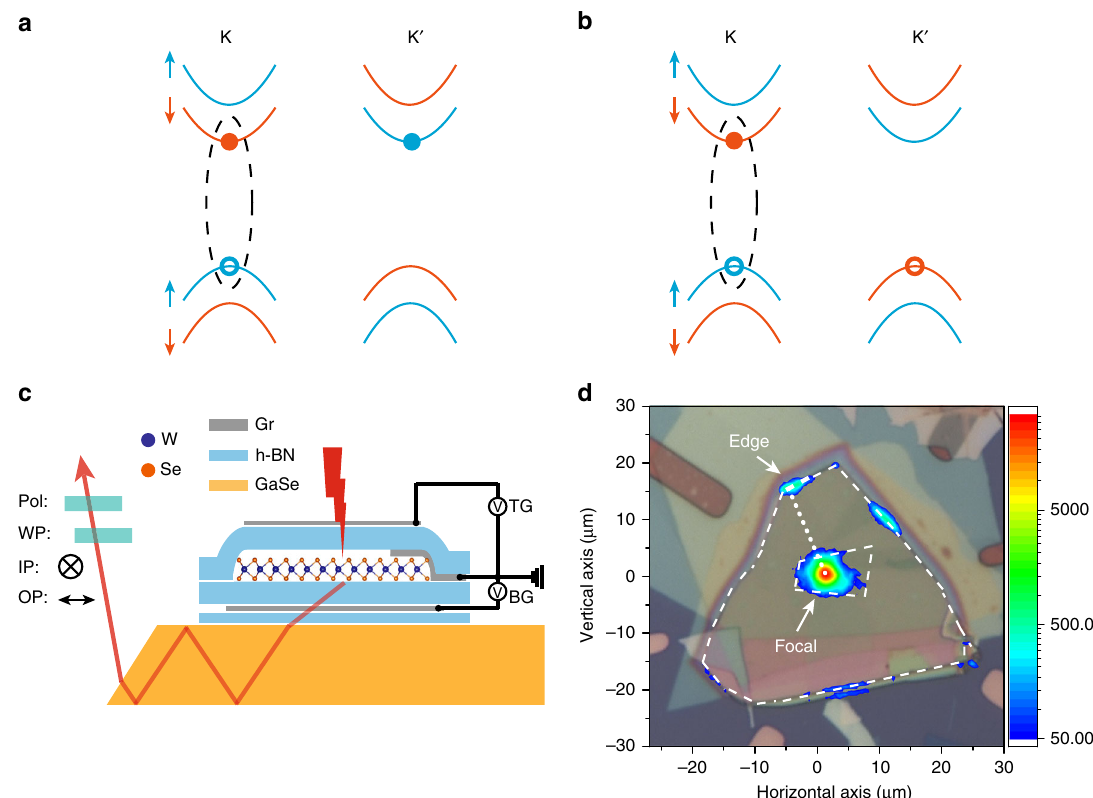
Fig. 1 Dark excitons in WSe 2 and experimental geometry. a , b Electronic con fi guration of a dark electron trion ( a ) and dark hole trion ( b ) in single-layer WSe 2 . Blue and orange curves represent electronic bands with electron spin up and spin down, respectively. The hole spin is opposite to what ’ s shown for the electron spin. Dashed ellipses indicate the electron-hole pairs involved in the recombination. c Schematic side view of a dual-gated WSe 2 device on a GaSe waveguide. WSe 2 is excited by a focused light beam (red lightning symbol) and the resultant PL guided by the waveguide (red arrowed line) is detected. The IP and OP emission dipoles are selected by a half-wave plate (WP) and a polarizer (pol). WSe 2 is grounded. TG and BG are the top and bottom gate voltages, respectively. d Optical re fl ection and PL images (overlaid) of a typical device. Inner and outer white dashed lines show the boundary of WSe 2 and GaSe, respectively. The dotted white line, which is perpendicular to the edge, is referred to as the focal-edge line. The color bar represents the PL